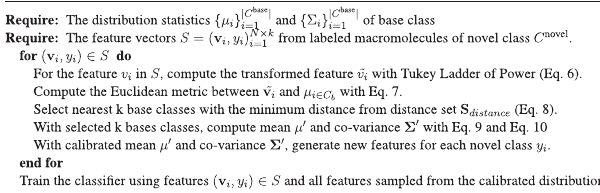
Algorithm 1. The training of the classi fi er in